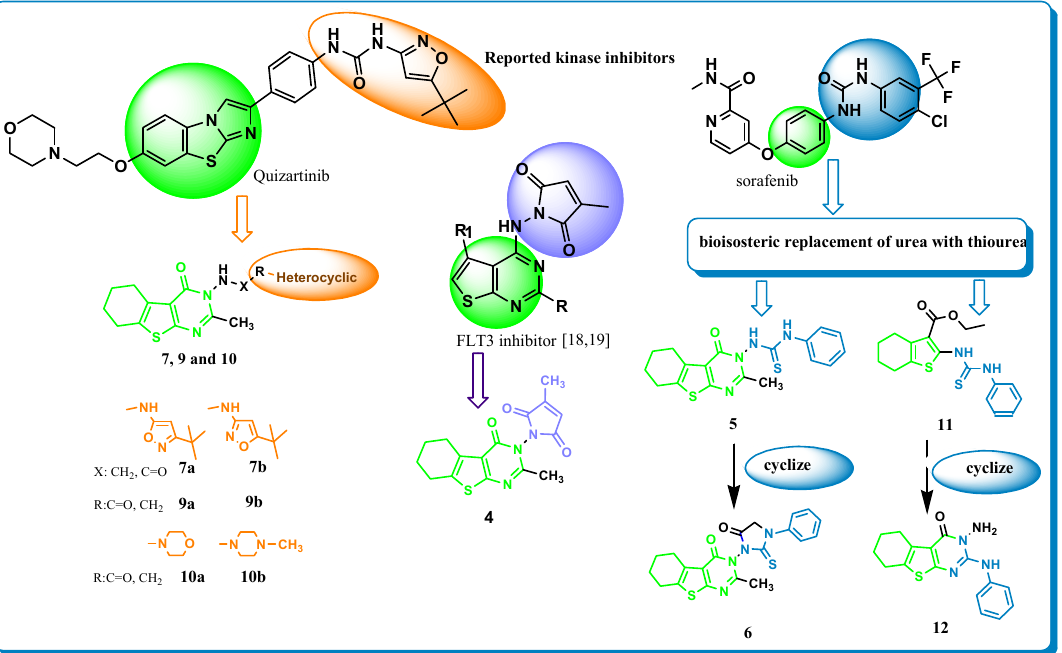
Figure 2. Design strategy for the synthesized compounds in relation to reported kinase inhibitors quizartinib and sorafenib.